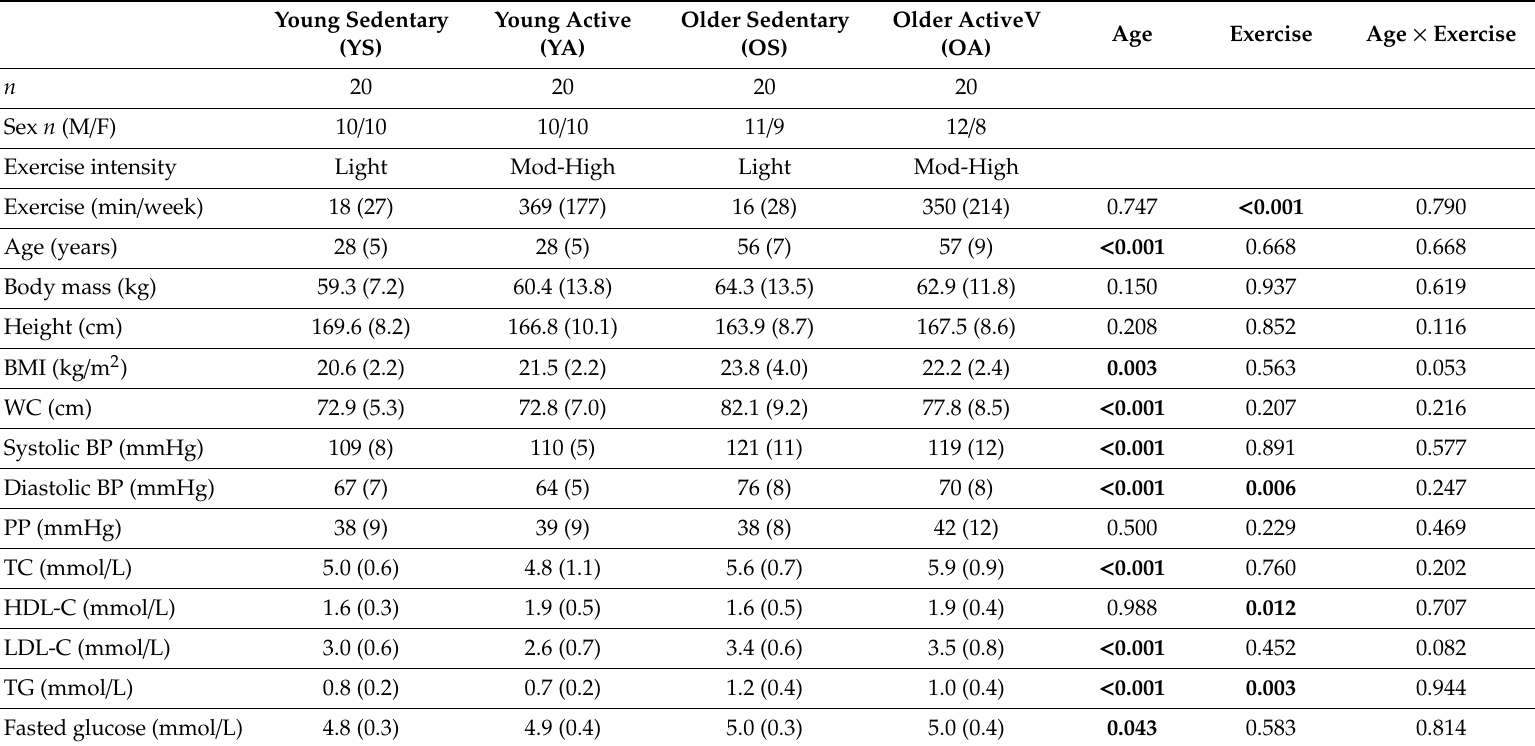
Table 1. Participant demographics, exercise history, anthropometry and blood